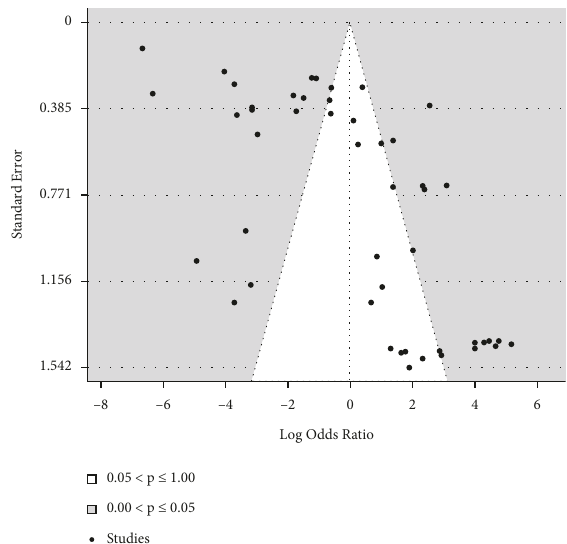
Figure 3: Funnel plot for all datasets. Effect size was taken as log odds ratio. Egger’s test results were as follows: Ran- dom-Effects Model ( k heterogeneity): 8.3860 (SE total variability): 97.84%, H 2 (total variability/sampling vari- ability): 46.22, Test for Heterogeneity: Q (df